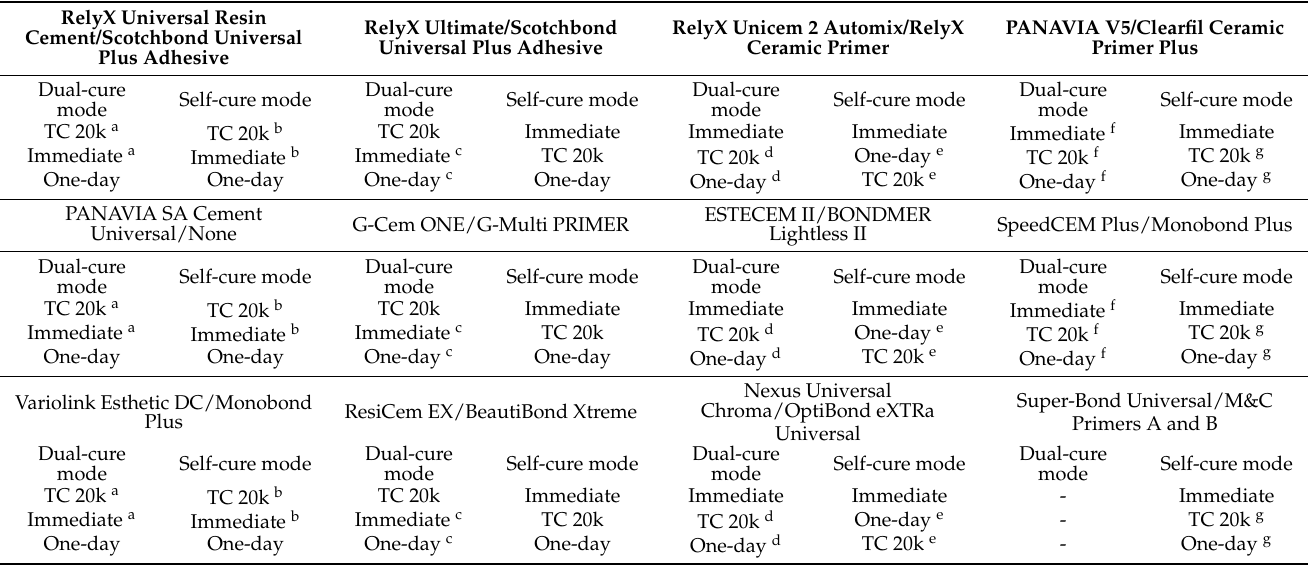
Table 4. Comparison of the means (Tukey HSD Procedure) for shear bond strength to LDS (e.max) of each adhesive resin cement material with regard to time [superscript letters (a–g) represent groups with no significant difference, p >